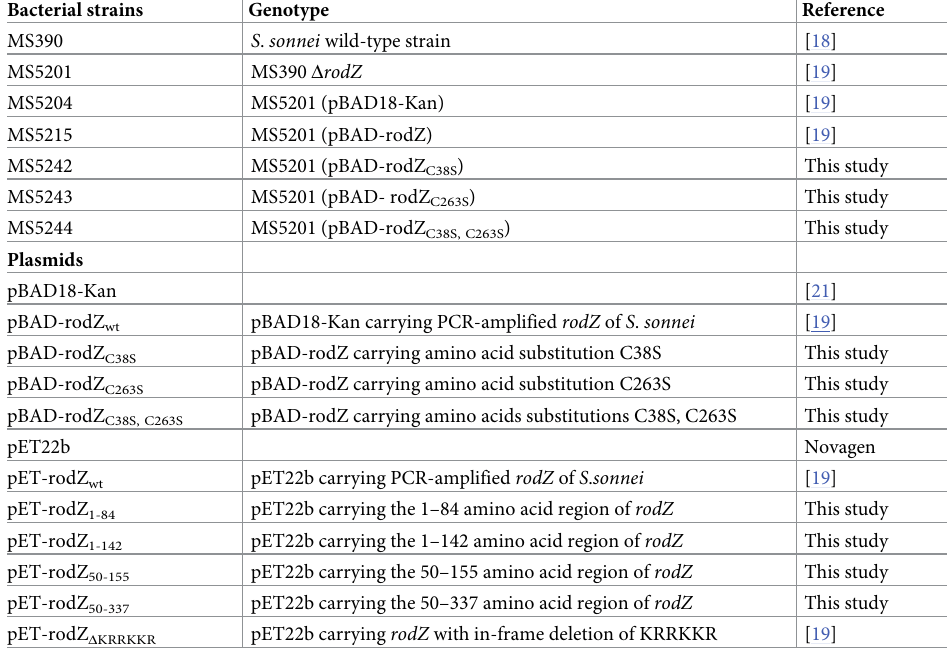
Table 1. Bacterial strains and